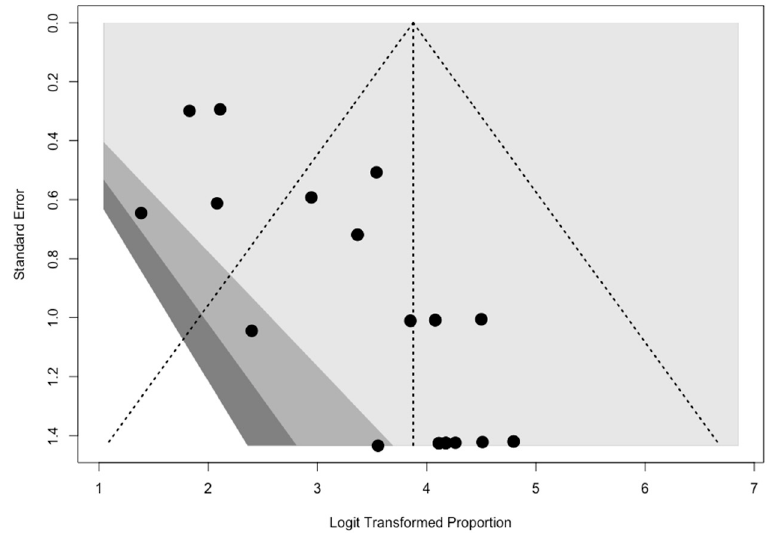
Figure A2. Funnel plot for specificity of studies included in the meta-analysis. Visual inspection suggested a significant asymmetry, with subsequent reporting bias.